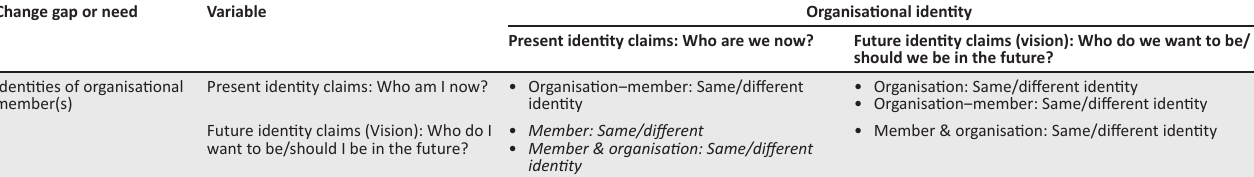
TABLE 1: Potential permutations of gaps in identity between the organisation and individuals. Change gap or need